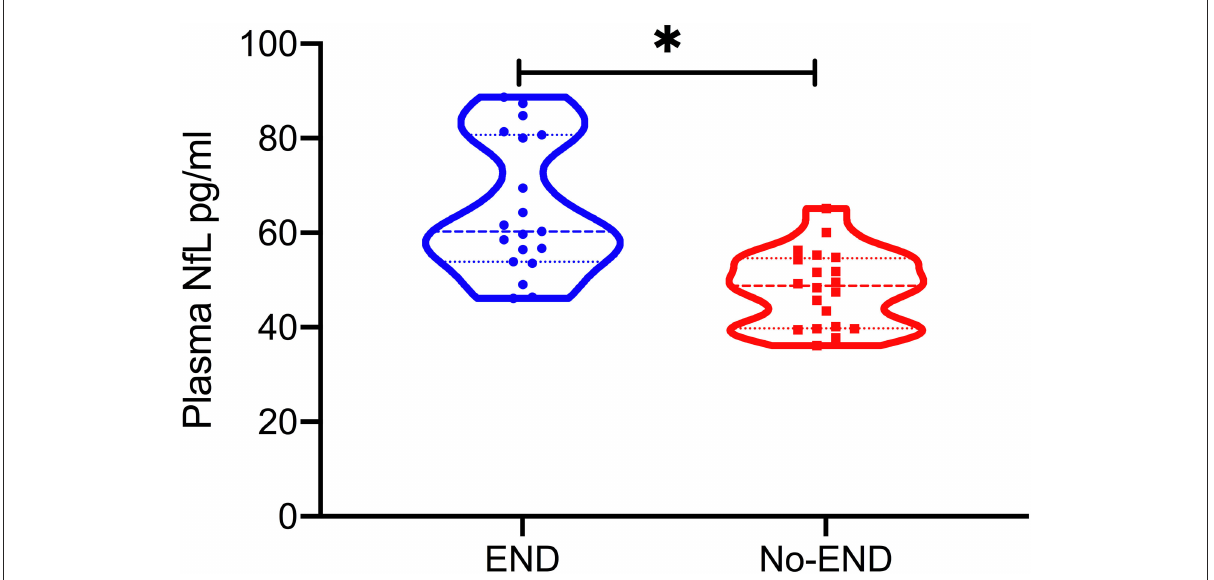
FIGURE1 Plasma neurofilament light chain (pNFL) concentration in the diagnostic groups is shown as scatterplots. The pNFL concentration was higher in the END group compared with the Non-END group ( * P <